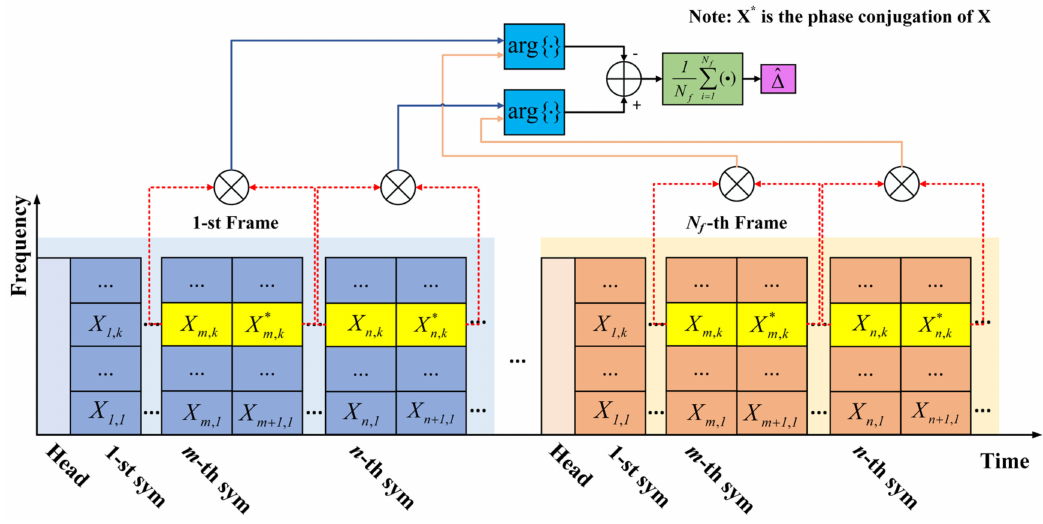
Figure 1. Principle of the SFO estimation based on the phase-conjugated